Question: Based on the figure, does the quantity rise or fall?
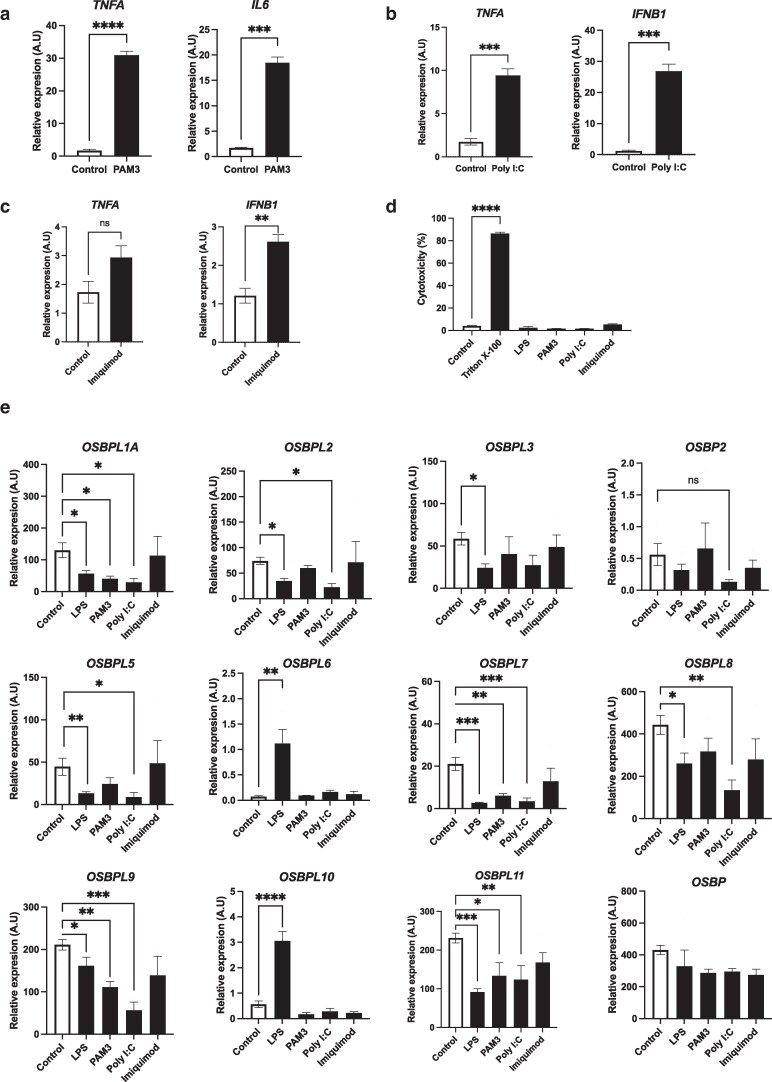
Answer: increasing